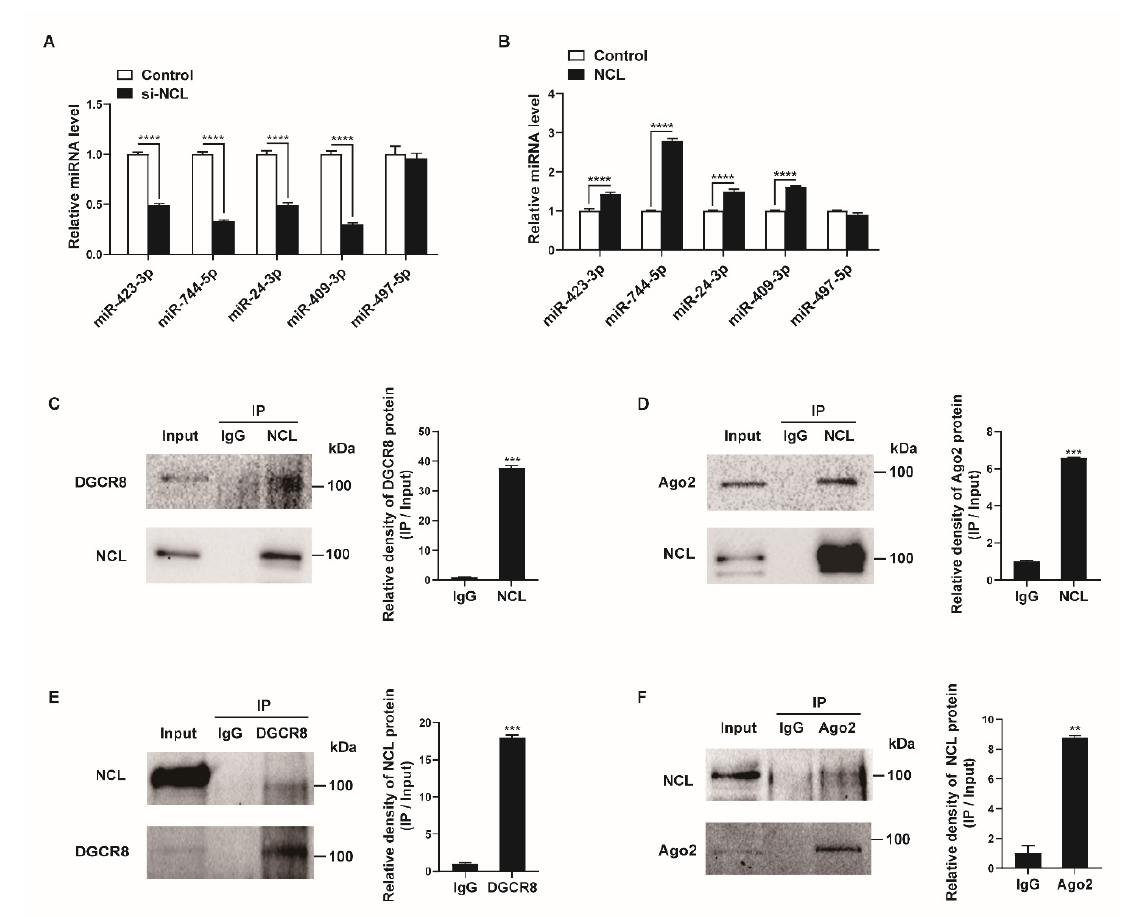
Figure 4. NCL expression affects specific miRNA levels. ( A , B ) Levels of the indicated miRNAs relative to U6 snRNA measured by qRT − PCR in PASMCs transfected with control or si − NCL for 24 h ( A ) or nucleofected with the control or NCL − expressing plasmid for 24 h ( B ). The data represent the mean ± S.E. of triplicate measurements of three independent experiments. ( C , D ) Immunoprecipitation assays from PASMC lysates were performed using an anti-NCL antibody or IgG. The presence of DGCR8, Ago2, and NCL in the pull-down and input (2%) samples was monitored by immunoblotting. Input: immunoblots showing the abundance of DGCR8, Ago2, or NCL in the total protein extracts. IP: IP products precipitated by the anti − NCL, anti − DGCR8, anti − Ago2 antibody, or IgG. ( E , F ) Immunoprecipitation assays from PASMC lysates were carried out using an anti ‐ DGCR8 antibody, anti − Ago2 antibody, or IgG. The presence of NCL, DGCR8, and Ago2 in the immunoprecipitates and input (2%) samples was monitored by immunoblotting. Statistical analyses were performed using two − way ANOVA Sidak’s multiple comparisons test ( A , B ) and two − tailed unpaired Student’s t − test ( C , F ). **, p < 0.005; ***, p < 0.0005; ****, p < 0.0001.